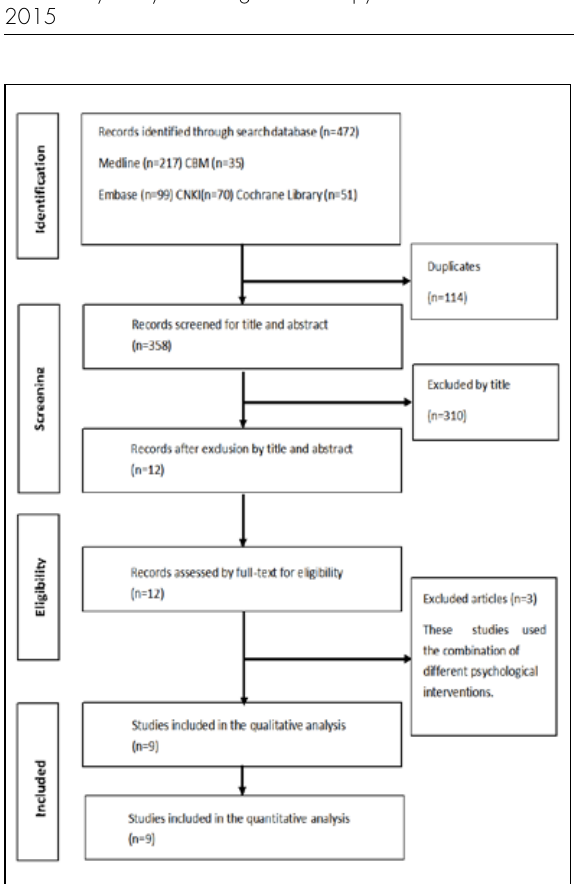
Figure 1. PRISMA flowchart for the steps of the systematic